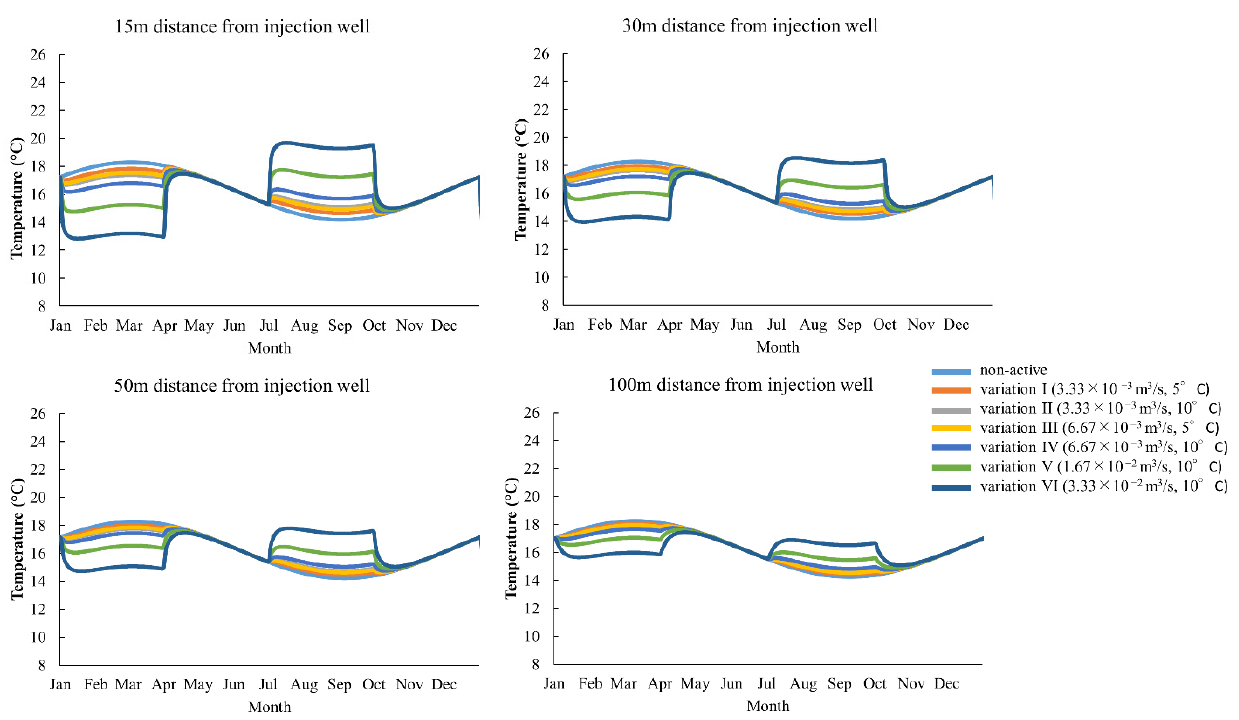
Figure 12. Thermal changes in local model 1 by open-loop GHP used in the downstream region at distances of 15, 30, 50, and 100 m from the injection well, with a variation of pumping rate and water injected temperature.